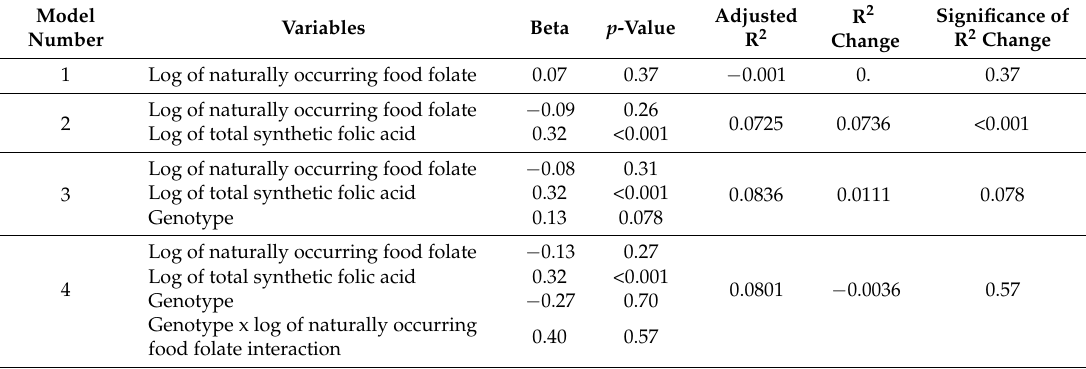
Table 4. Predictors of red blood cell (RBC) folate via hierarchical linear regression ( n = 180). Model